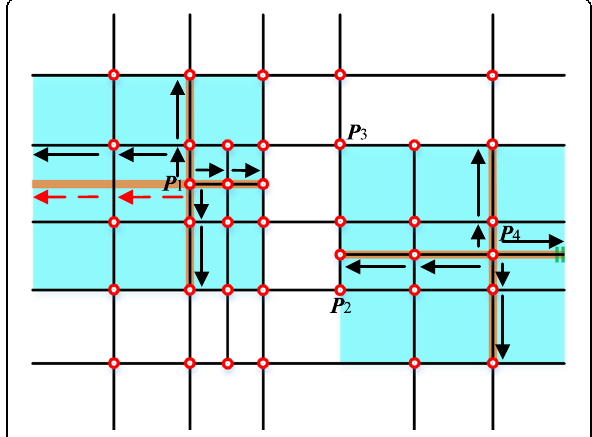
Fig. 7 Initial half-edges in the local parametric algorithm